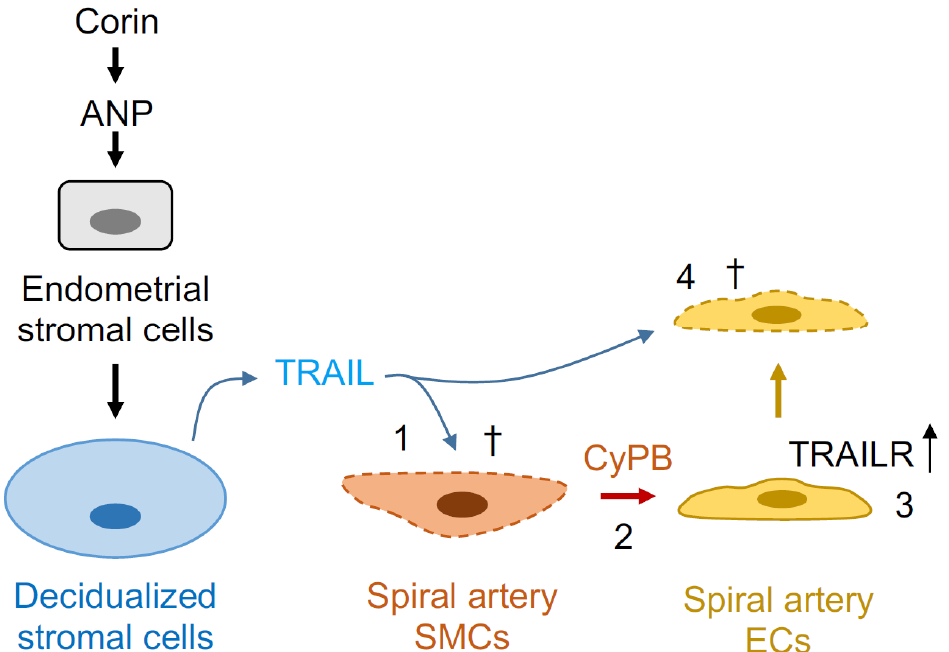
Figure 4. A proposed mechanism of corin and ANP in uterine spiral artery remodeling. In preg- nancy, corin is expressed in the uterus to activate ANP, which promotes decidualization of uterine stromal cells and TNF-related apoptosis-inducing ligand (TRAIL) expression. TRAIL released from decidualized stromal cells induces apoptosis (†) in spiral artery smooth muscle cells (SMCs) (1) and cyclophilin B (CyPB) release (2). CyPB, in turn, upregulates TRAIL receptor (TRAILR) expression in spiral artery endothelial cells (ECs) (3), thereby causing TRAIL-mediated apoptosis in ECs (4).